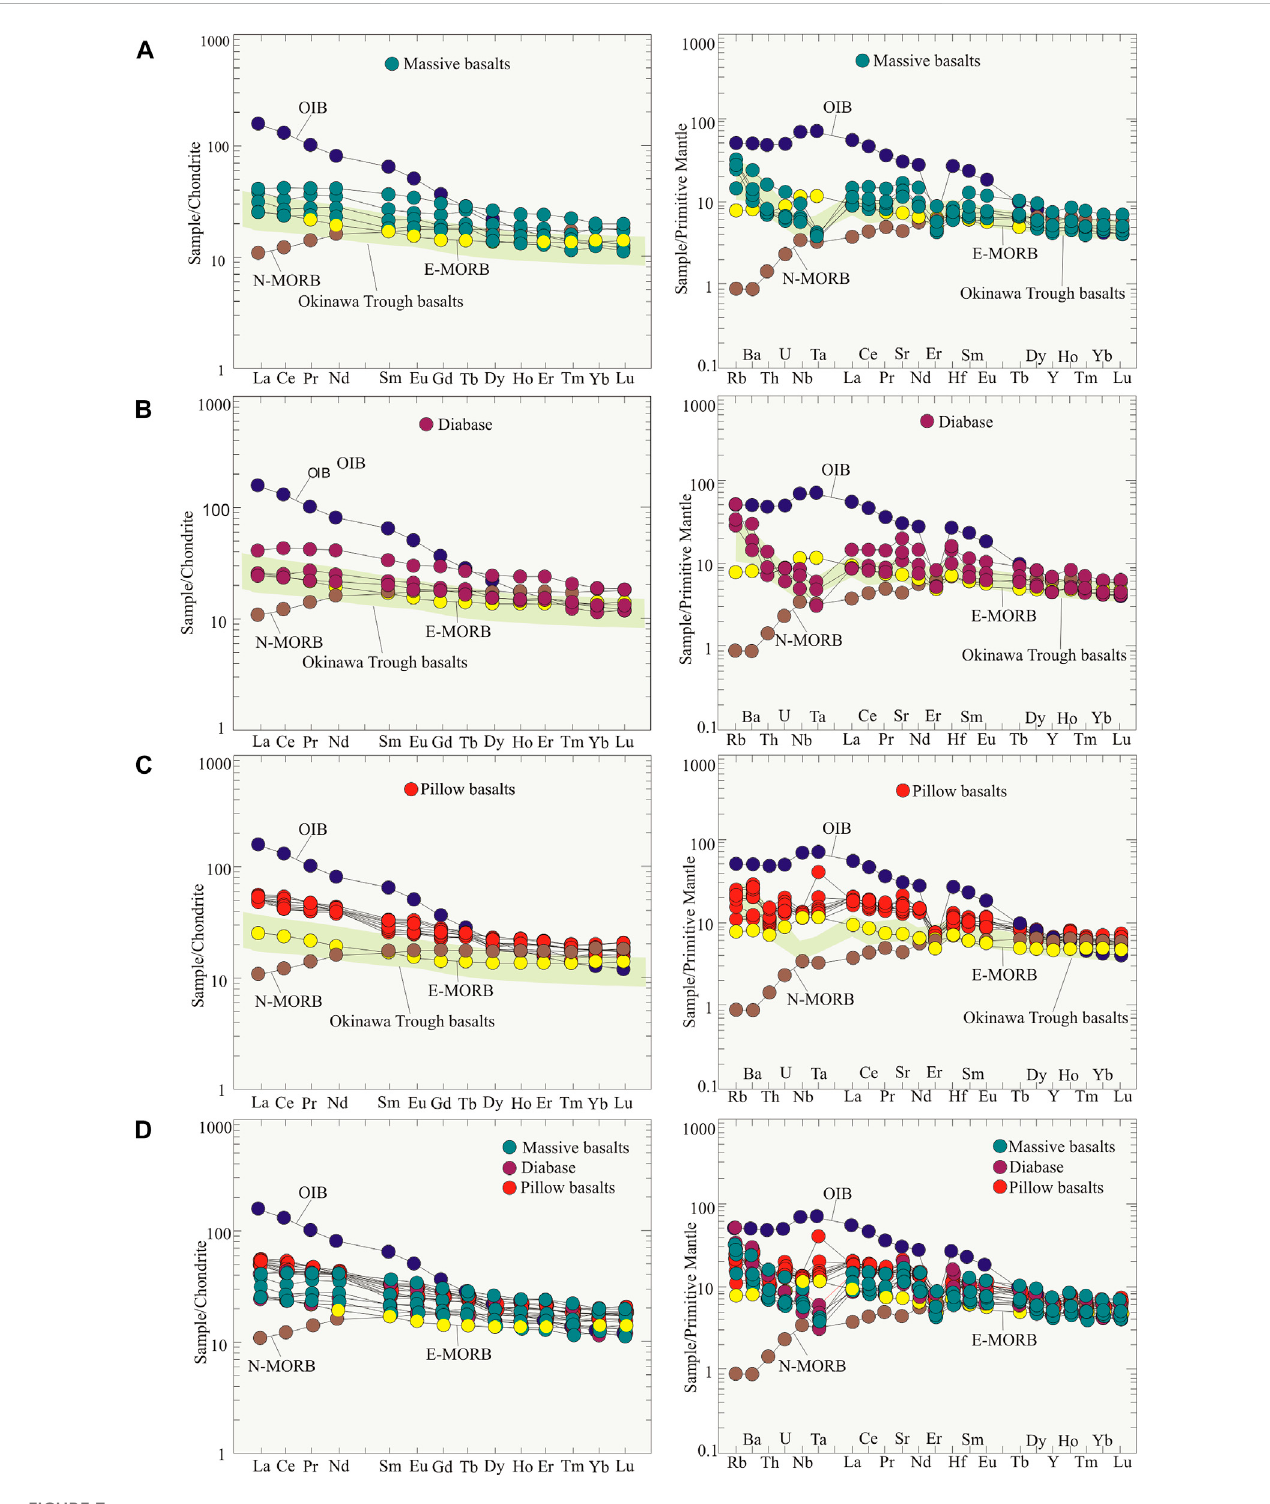
FIGURE 7 Rareearthelement(REE)patterns andprimitivemantle-normalized incompatibleelementdiagramsofthebasic igneous rocksintheBairinRight Banner area, Inner Mongolia. Chondrite and primitive mantle-normalized values are from Boynton, (1984); Sun and McDonough, (1989), respectively; Normal Mid- Ocean Ridge Basalt (N-MORB), Enriched Mid-Ocean Ridge Basalt (E-MORB) and Ocean Island Basalt (OIB) values are from Sun and McDonough, (1989). (A) massive basalts; (B) diabases; (C) pillow basalts; (D) . Basic igneous rocks in Bairin Right Banner.